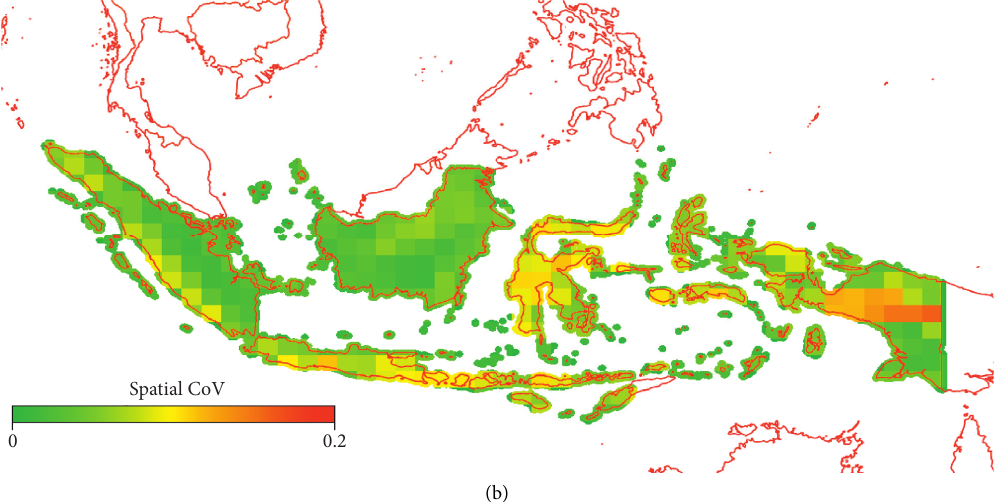
Figure 6: The spatial CoV loss figure due to downscaling. (a) SolarGIS to CLARA-A2. (b) SolarGIS to